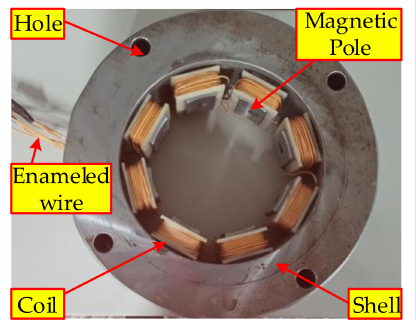
Figure 3. Photo of the radial unit.